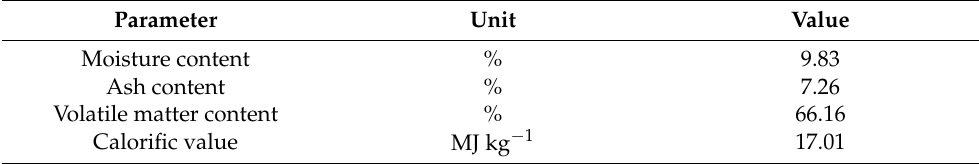
Table 9. Results of the technical analysis of the biomass fuel.